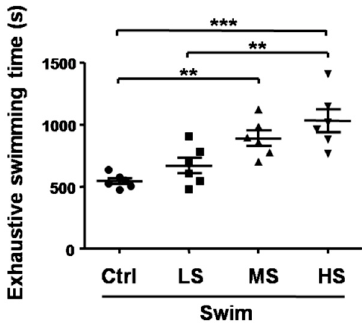
Figure 3. The effects of Salecan on the exhaustive swimming times of mice from four groups. Data are expressed as mean ± SD, N = 6, ** p < 0.01, *** p < 0.001. Swim-Ctrl, the control group; Swim-LS, the low-dose of Salecan-treated group; Swim-MS, the medium-dose of Salecan-treated group; Swim-HS, the high-dose of Salecan-treated group.